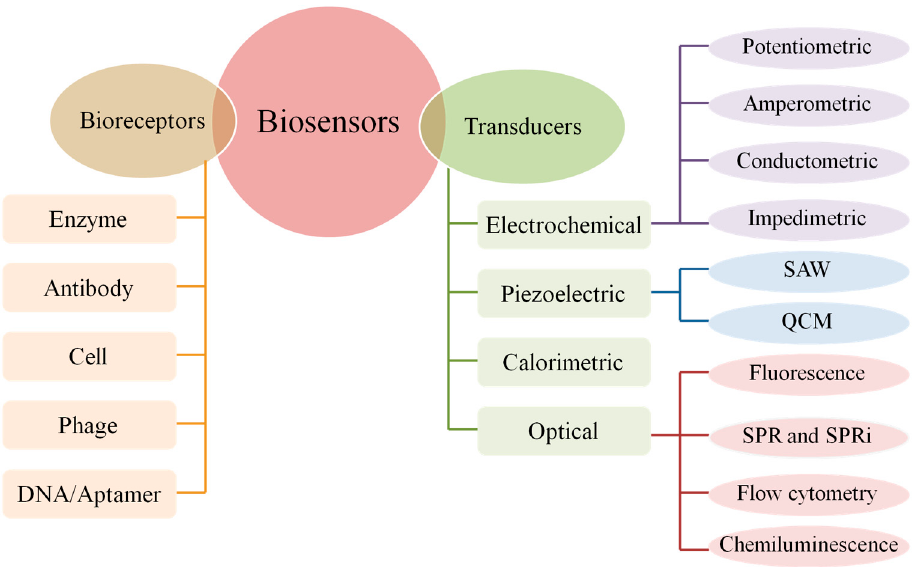
Figure 1. Components and classification of biosensor.